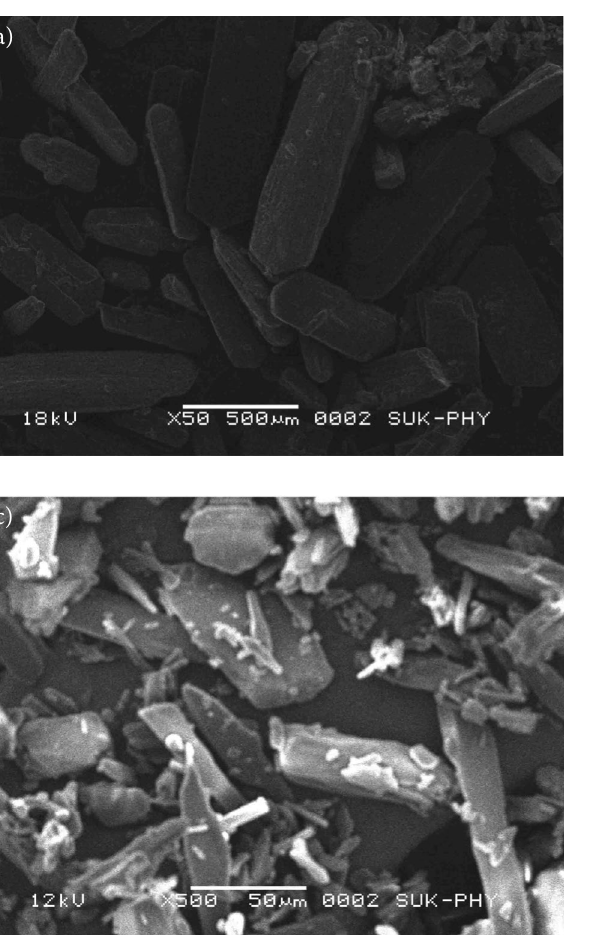
Figure 4. Scanning electron microphotograph of (a) IB [50x], (b) IB [100 x], (c) PA [500x] and (d) COAM 1